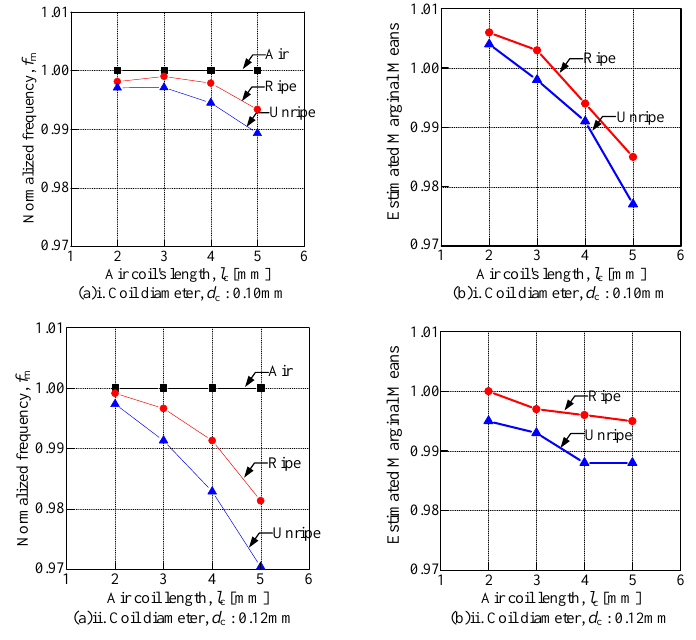
Figure 8. Effects of coil diameter. ( a ) The N f ( b ) The estimated marginal means versus air coil